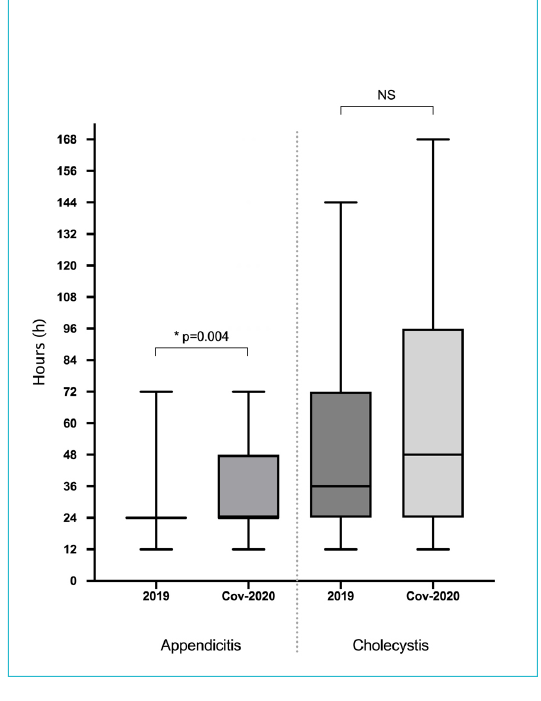
Figure 1: Delay (hours) to consultation in the emergency room af- ter first symptoms for appendicitis and cholecystitis: comparison between 2019 and 2020. Appendicitis: p = 0.004, cholecystitis: p = 0.284. Median (interquartile range), NS: non-significant.